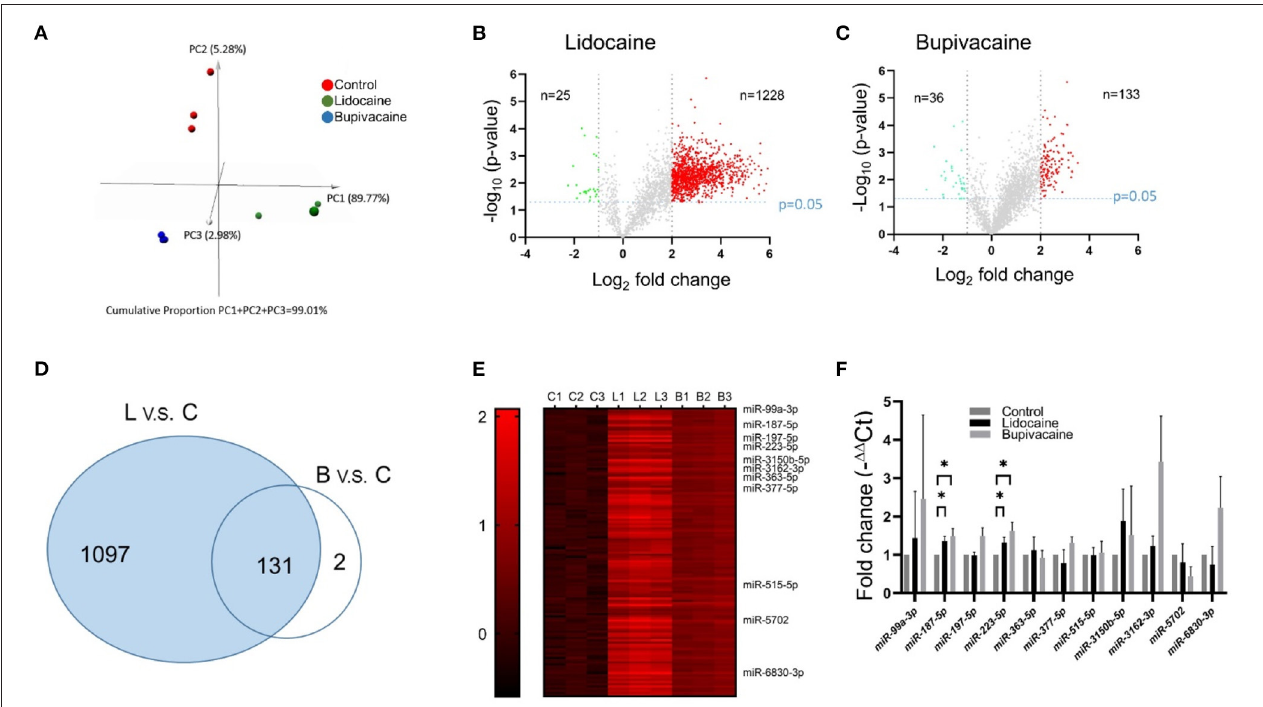
FIGURE 2 | Identification of miRNAs in MCF-7 cells that responded to treatment with lidocaine or bupivacaine. (A) PCA of differentially expressed miRNAs in response to treatment with lidocaine (4mM) or bupivacaine (1mM). (B,C) Volcano plot of the differentially expressed miRNAs in response to treatment with lidocaine (B) or bupivacaine (C) determined by next-generation sequencing. (D) Venn diagram of the differentially expressed miRNAs. The expression of 131 miRNAs was upregulated following treatment with lidocaine or bupivacaine. (E) Heat map of the upregulated miRNAs ( n = 131) that responded to treatment with both lidocaine and bupivacaine. (F) PCR validation of the selective differentially expressed miRNAs in MCF-7 cells, following treatment with lidocaine and bupivacaine. The expression levels measured using qRT-PCR and normalised to that of U6 snRNA. L, lidocaine; B, bupivacaine; C, control. All data are presented as mean ± SD ( n = 3). * p <